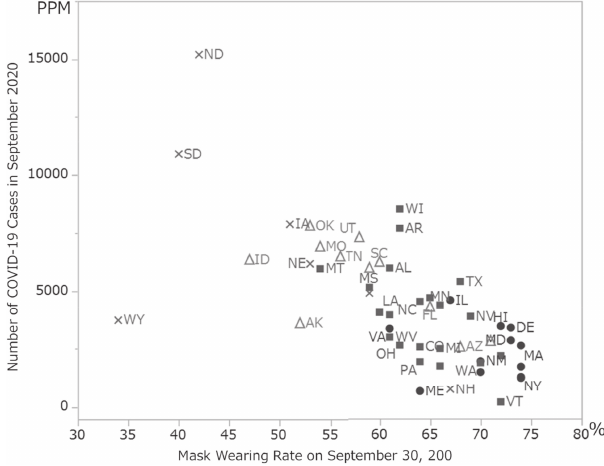
Figure 3. Number of